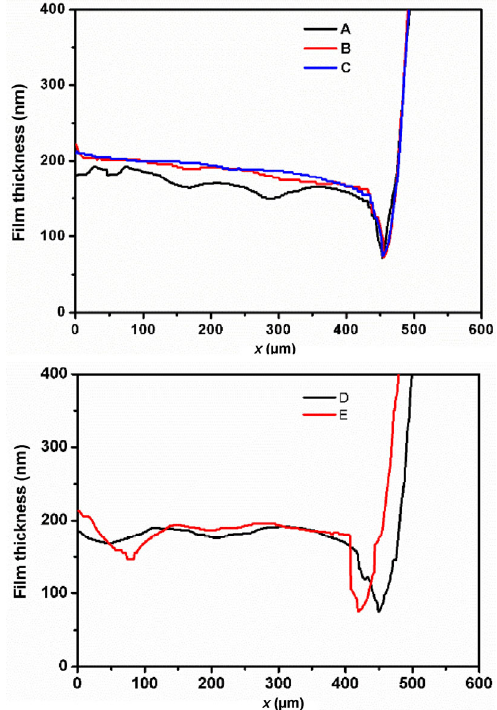
Fig. 12 Film thickness for aluminum-complex-based grease and lithium-based grease with different thickener concentrations ( u = 15 mm/s, p max =0.58 GPa, straight line profile).